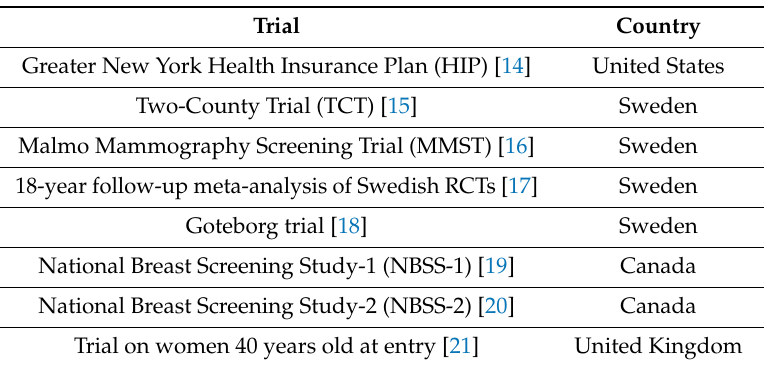
Table 1. Randomized trials in mammography